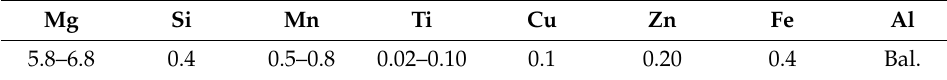
Table 2. Chemical composition of 5A06 aluminum alloy (wt.